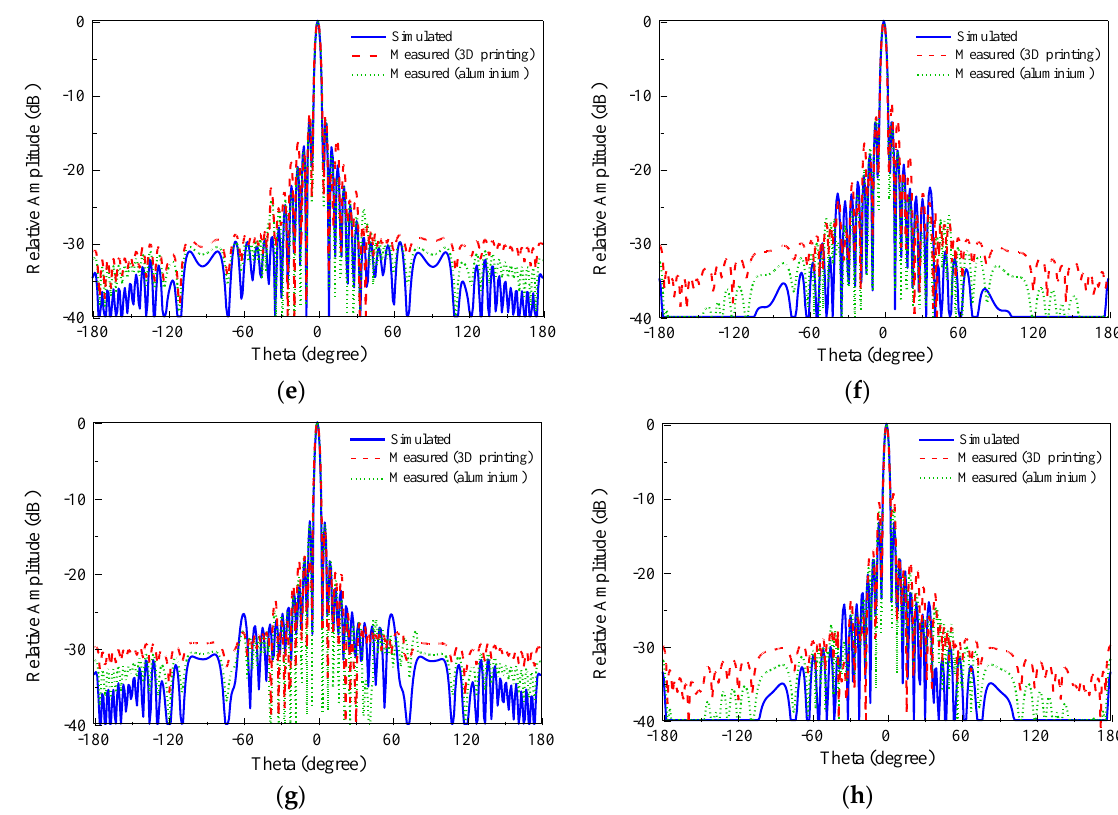
Figure 4. Measured and simulated performances of the 16 × 16 complementary dipole antenna array: ( a ) reflection coefficients; ( b ) gains; ( c ) radiation patterns on phi = 0° at 25.74 GHz; ( d ) radiation patterns on phi = 90° at 25.74 GHz; ( e ) radiation patterns on phi = 0° at 27.80 GHz; ( f ) radiation patterns on phi = 90° at 27.80 GHz; ( g ) radiation patterns on phi = 0° at 29.85 GHz; ( h ) radiation patterns on phi = 90° at 29.85 GHz.